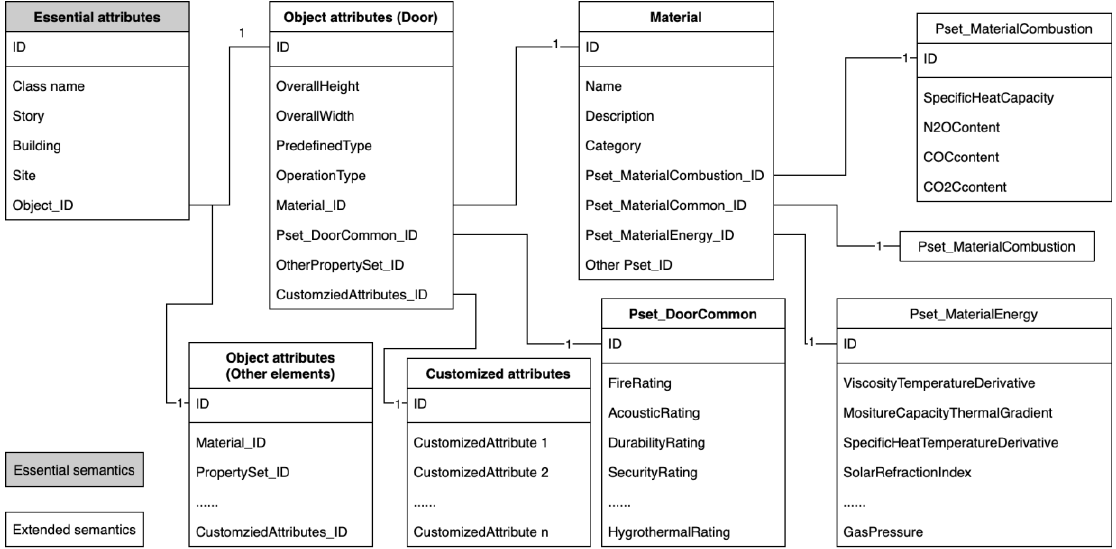
Figure 10. Essential semantics and extended semantics.